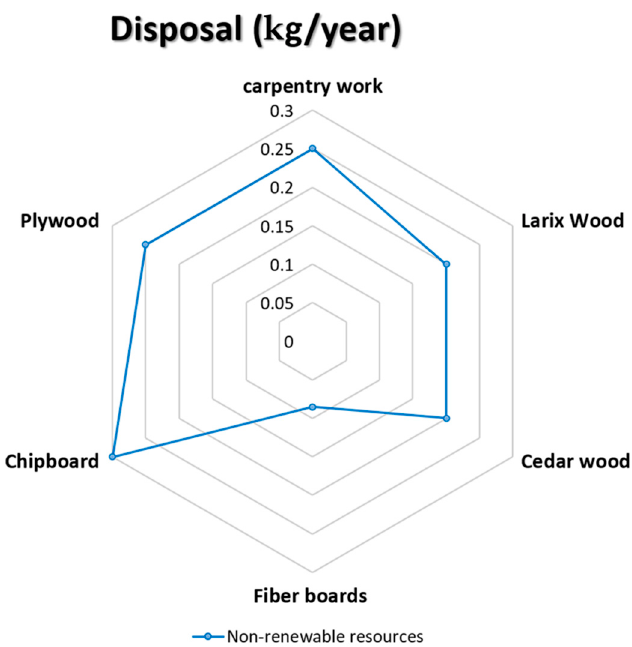
Figure 12. Shows the impact of disposal on the selective façade wooden material [68–72].